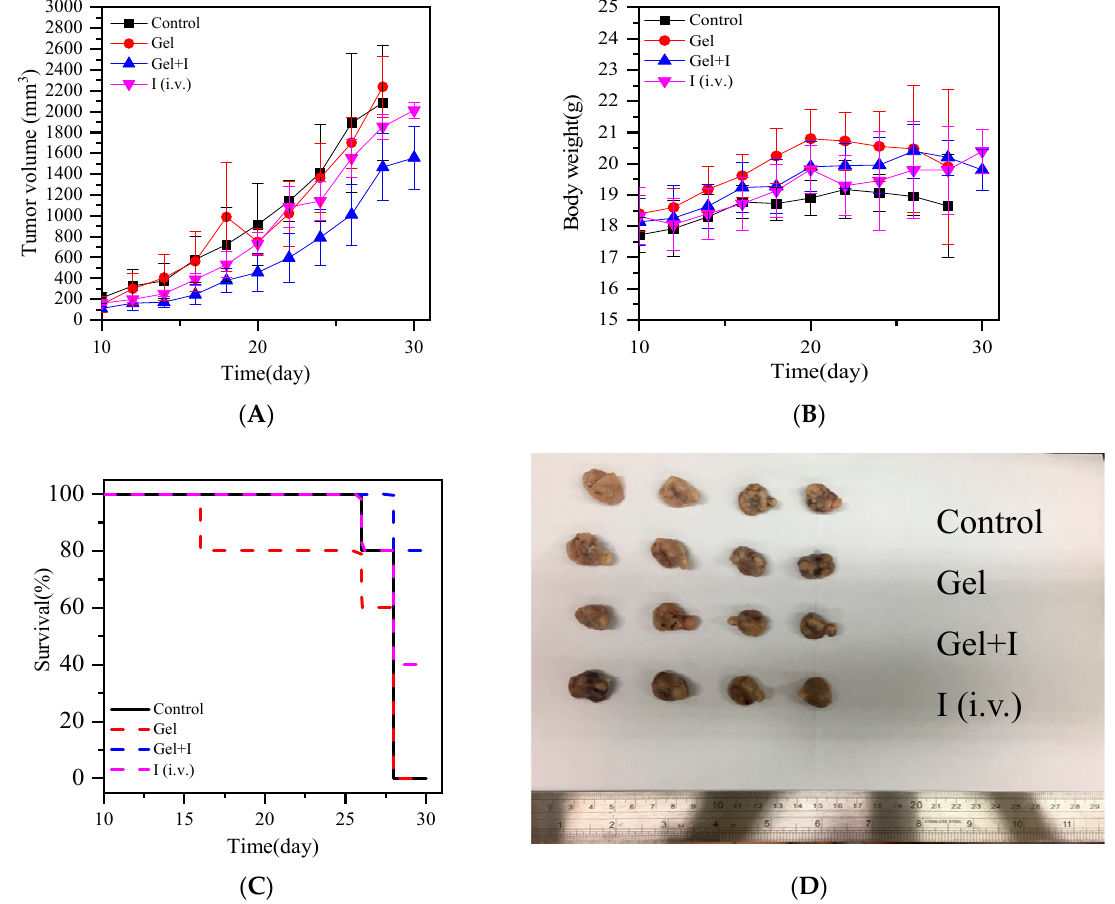
Figure 8. Breast cancer therapy assessment of liposome–hydrogel carriers: ( A ) tumor suppression ability analysis, ( B ) analysis of animal weight changes, ( C ) animal survival rate analysis, and ( D ) actual tumor sizes.